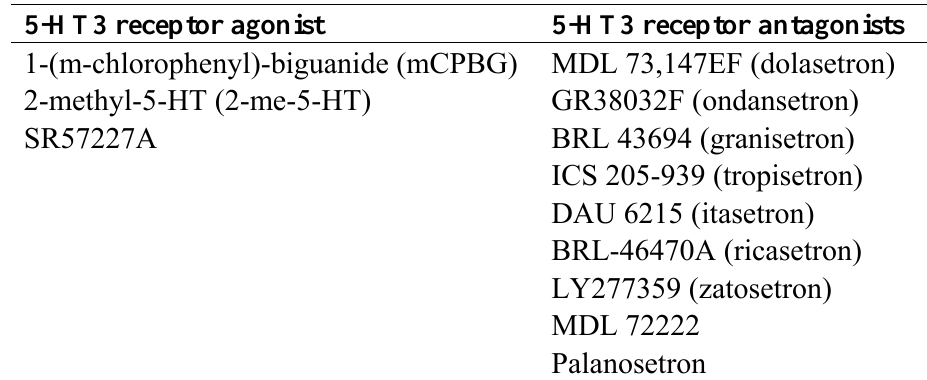
receptor agonists and Table 1. 5-HT 3